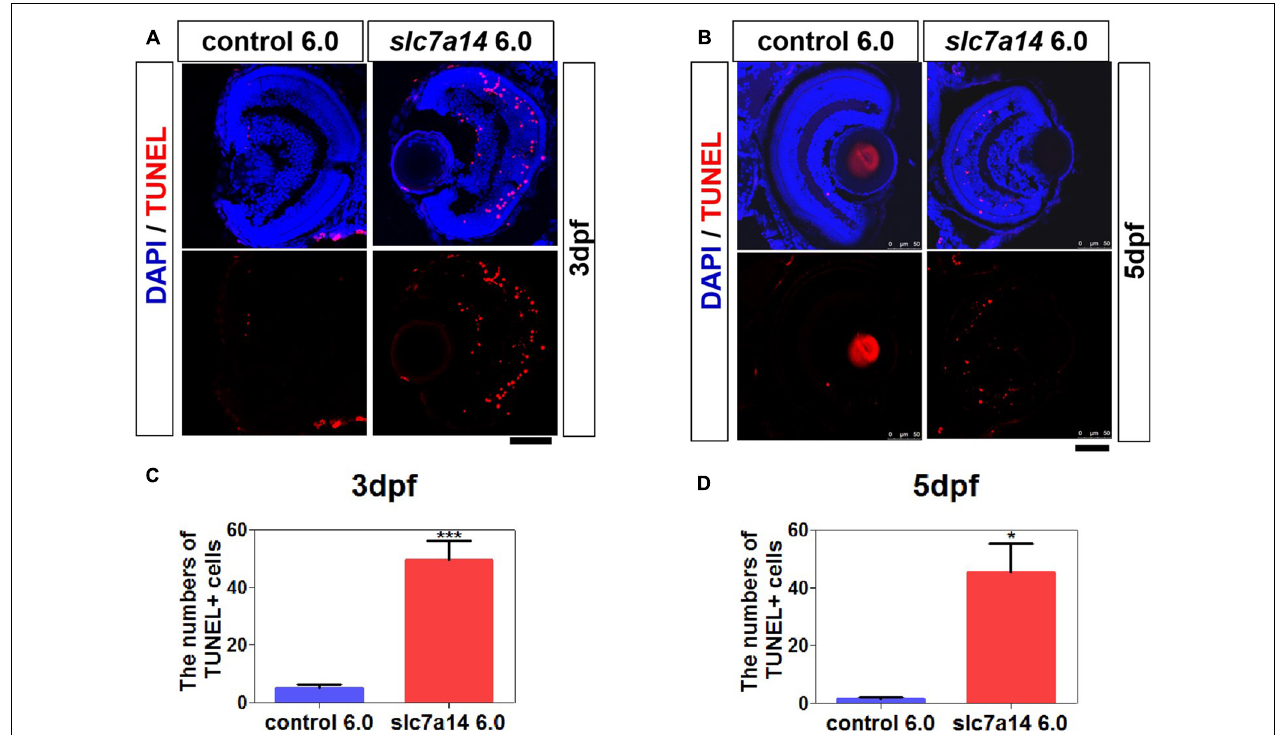
FIGURE 4 | Knockdown of slc7a14 led to increased apoptosis in the zebrafish retina. TUNEL assay was used to detect apoptosis in larval retinas at 3 and 5 dpf. (A,B) Slc7a14 knockdown resulted in significant increase of TUNEL + cells in the retina including GCL, INL, ONL and RPE at 3 dpf (A) and 5 dpf (B) . Scale bars = 50 µ m. (C,D) Statistical results for the numbers of TUNEL positive cell at 3 dpf ( n = 6 for each group ) and at 5 dpf ( n = 3 for each group). Bar plots were shown as the mean ± s.e.m. T -test was performed between the two groups. ∗ P < 0.05, ∗∗∗ P <